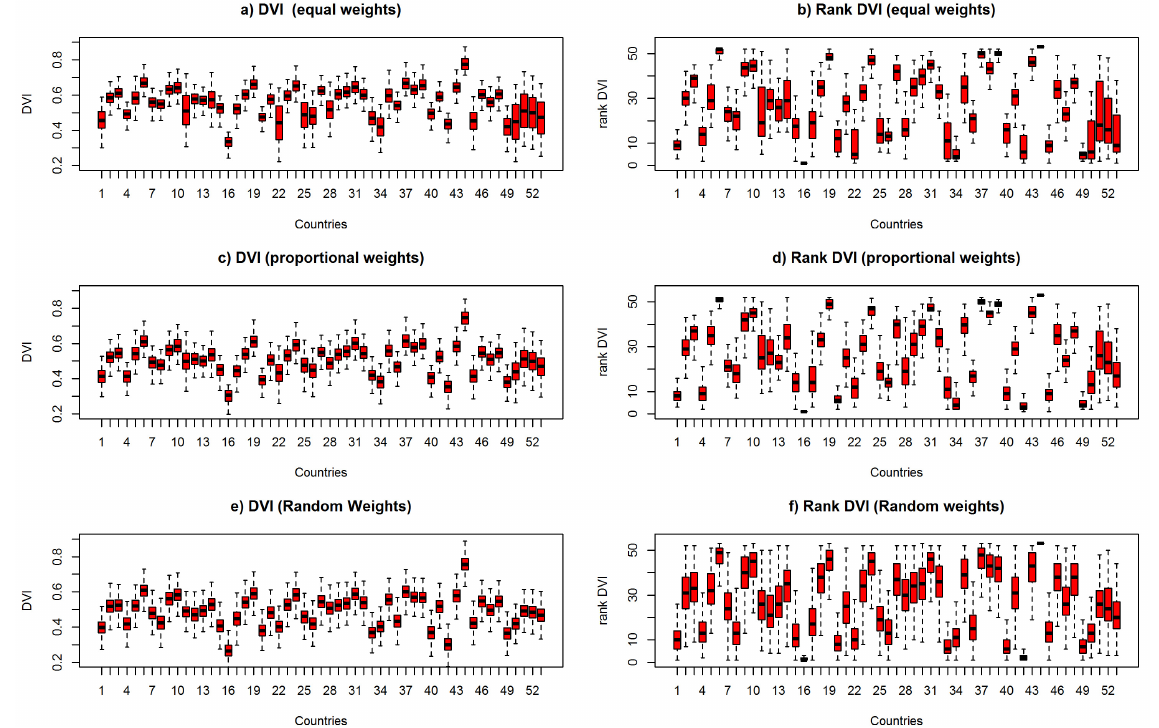
Fig. 4. Summary of the estimated DVI values (left) and their related country ranking (right) for the three weighting schemes ( a, b : equal weights, c, d : proportional weights and e, f : random weights). Dashed lines extend from 5th to 95th percentile of estimations, boxes extend from 25th to 75th percentile and middle horizontal lines within each box indicate the median for each country. The countries were numbered following their alphabetical order (see Fig. 7 for the corresponding